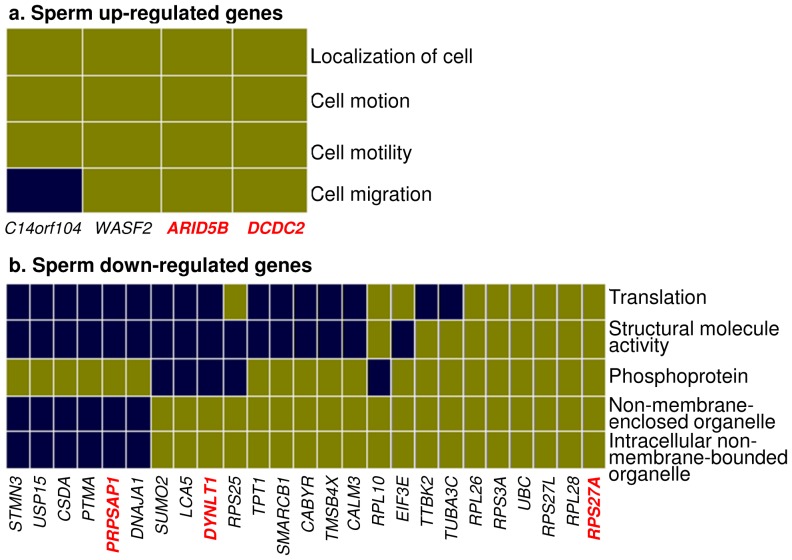
Heat maps of GO functional groups for sperm up-regulated (a) and sperm down-regulated (b) transcripts.Blue boxes denote that the gene has not been associated with the corresponding GO category. Genes with symbols in red font were validated by qRT-PCR.